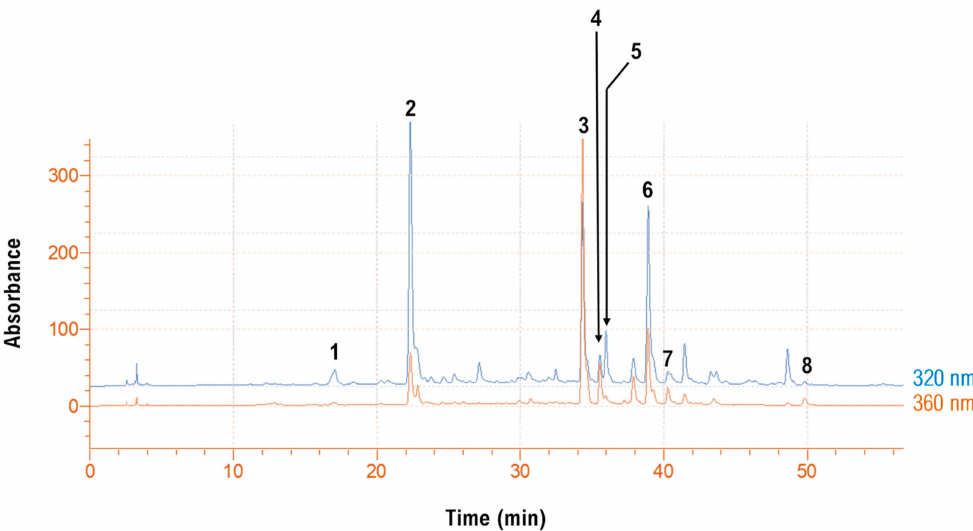
Figure 6. HPLC traces of the extract obtained with 10-min ultrasonication pretreatment, under optimal conditions, with LA-Gly (5:1). Traces were recorded at 320 (hydroxycinnamates) and 360 (flavonols) nm. With regard to flavonols, peak #3 yielded a pseudo-molecular ion at m / z = 611 and fragment ion at m / z = 303. These data, along with the retention time of the original standard, enabled the identification of this substance as rutin (quercetin 3- O